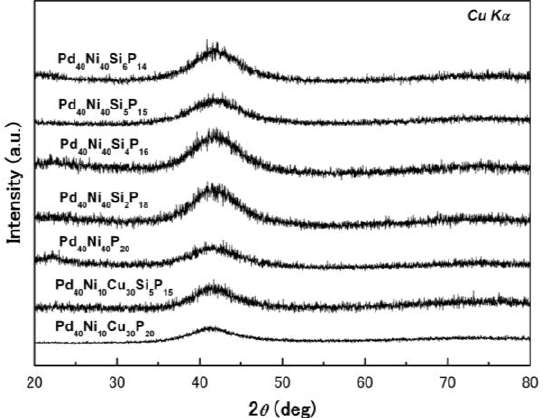
Ni Si P (x = 0–6) and Pd 40 40 x 20−x